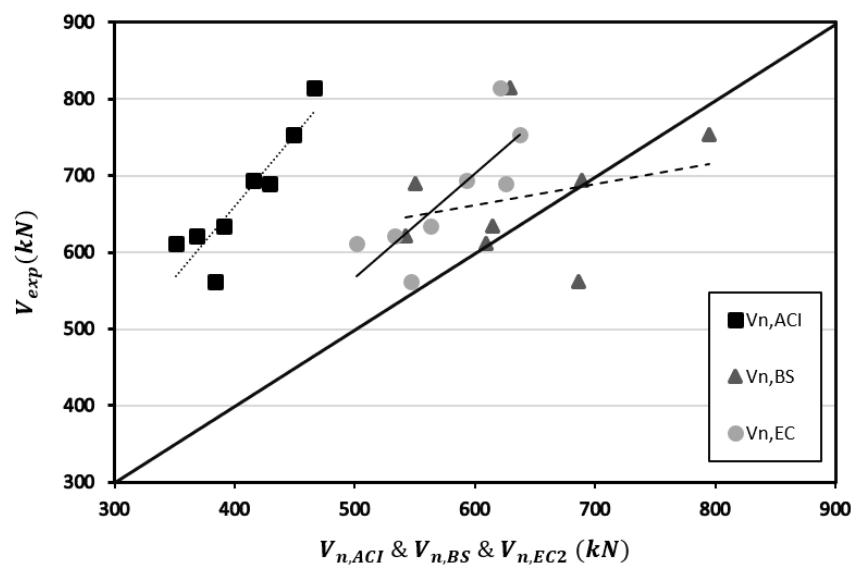
Figure 10. Comparison between the calculated and experimental maximum shear.